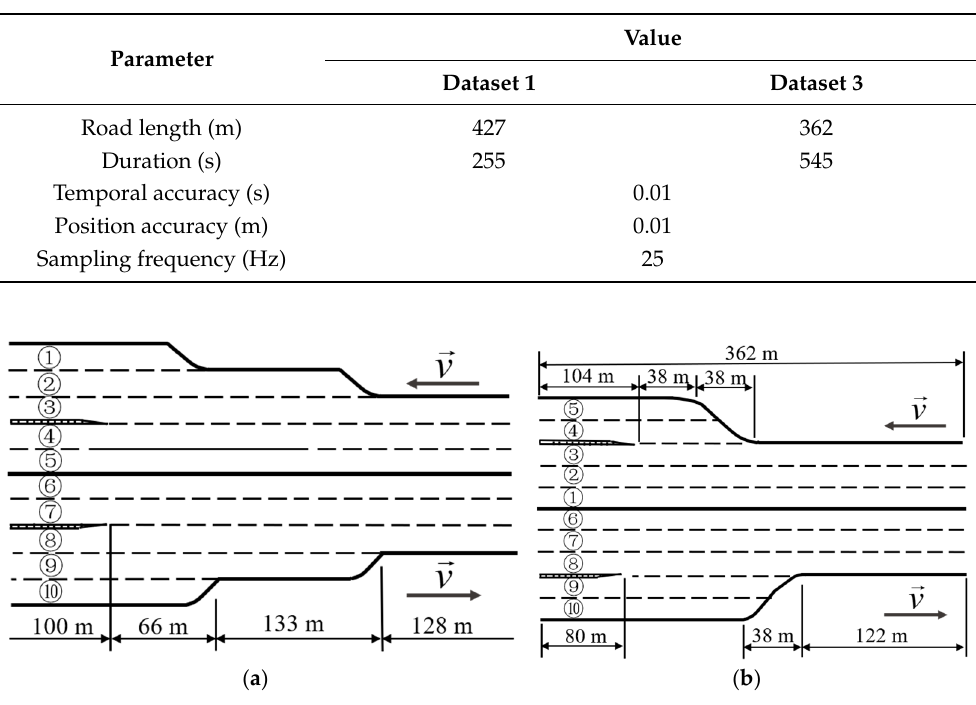
Figure 1. Schematic diagram of lane distribution, where ( a ) is dataset 1 and ( b ) is dataset 3.